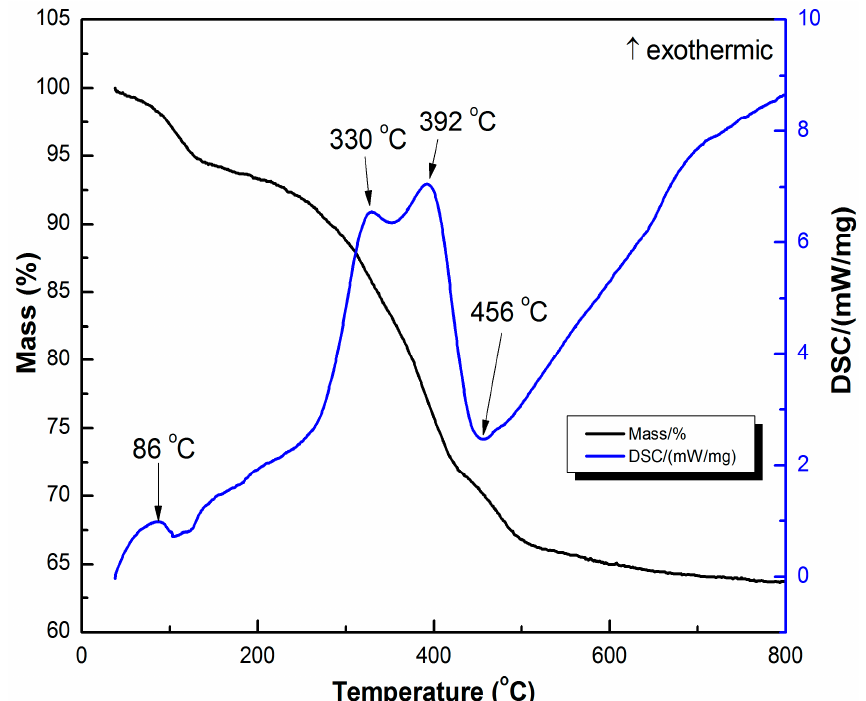
Figure 1. Thermogravimetry–differential scanning calorimetry (TG–DSC) curve of sample MCTO-0. The XRD patterns of the MCTO-0, MCTO-400, MCTO-500, MCTO-600, and MCTO-700 are